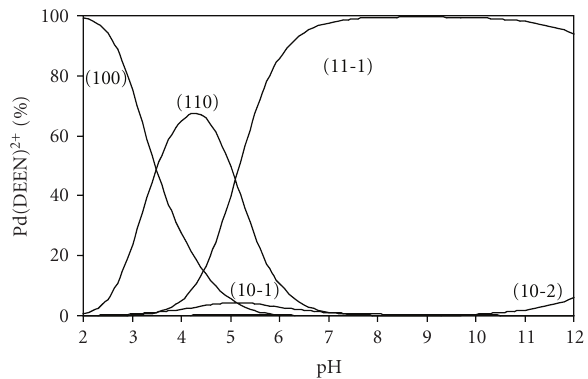
Figure 3: Concentration distribution diagram for various complex species in Pd(DEEN) 2+ -glycylglycine system.